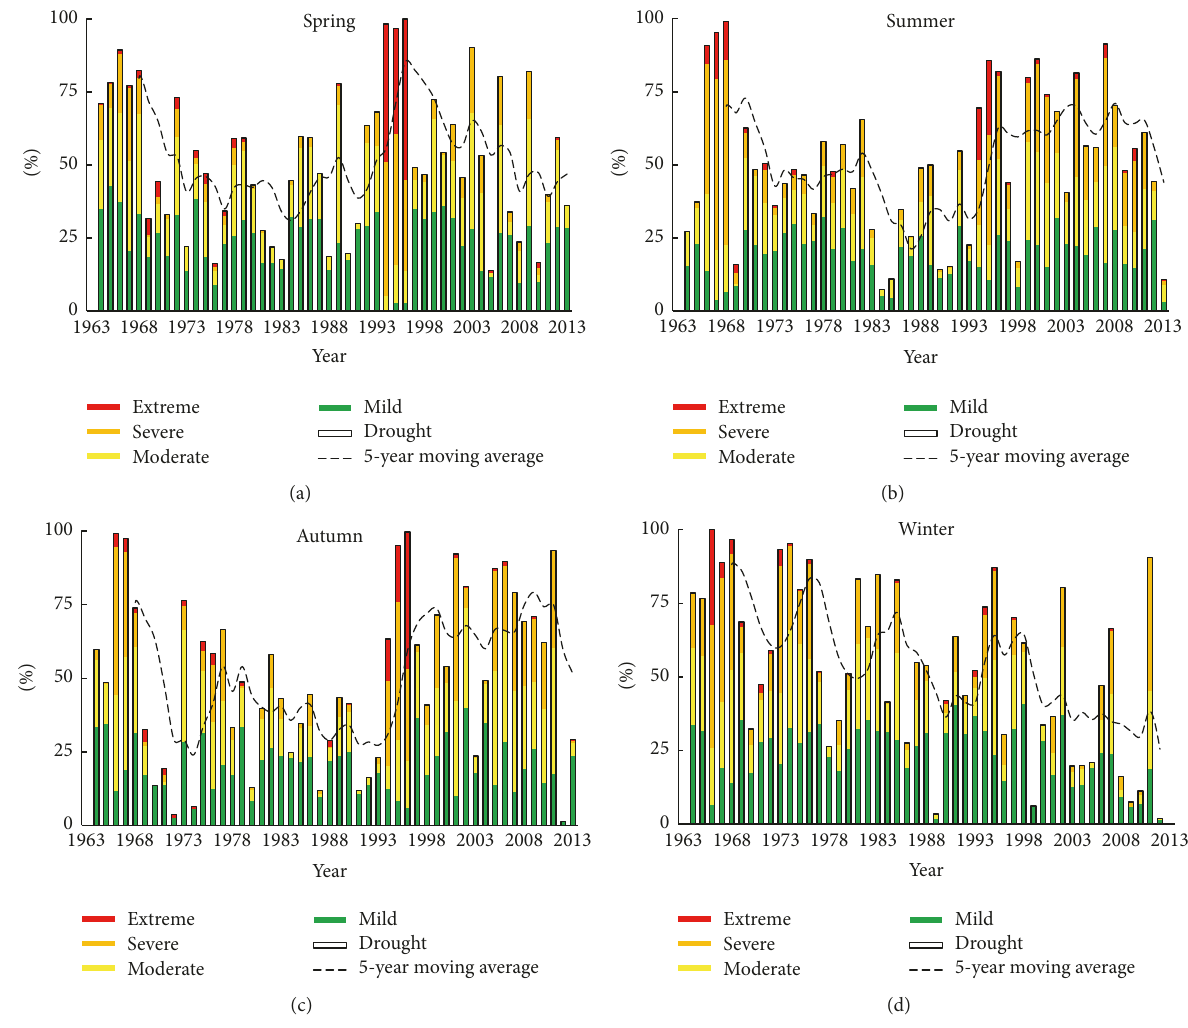
Figure 6: The interannual variability of drought area in four seasons.